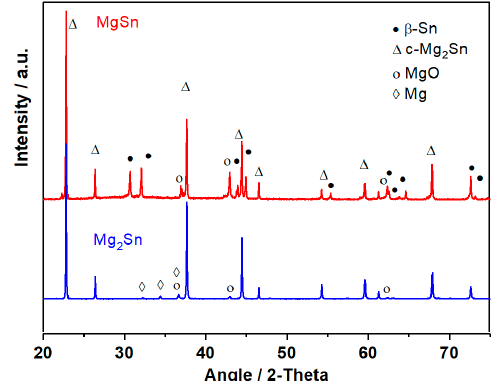
Figure 1. Powder X-ray diffraction (XRD) patterns of the thermally prepared samples with Mg 2 Sn and MgSn nominal compositions.